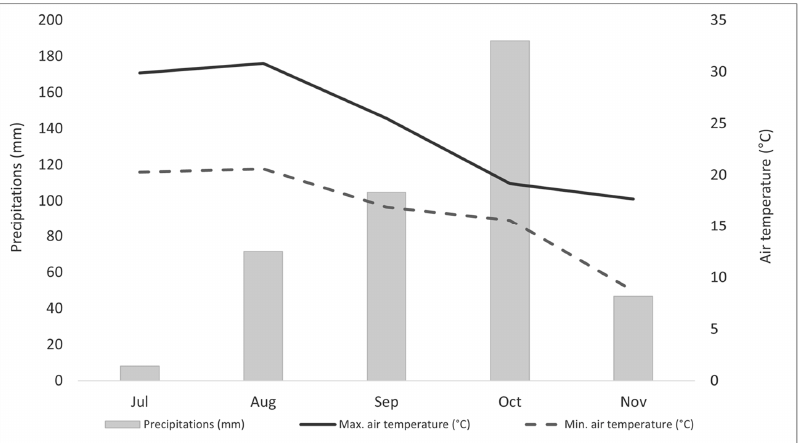
Figure A1. Diagram of precipitation and air temperature between July and November 2020.